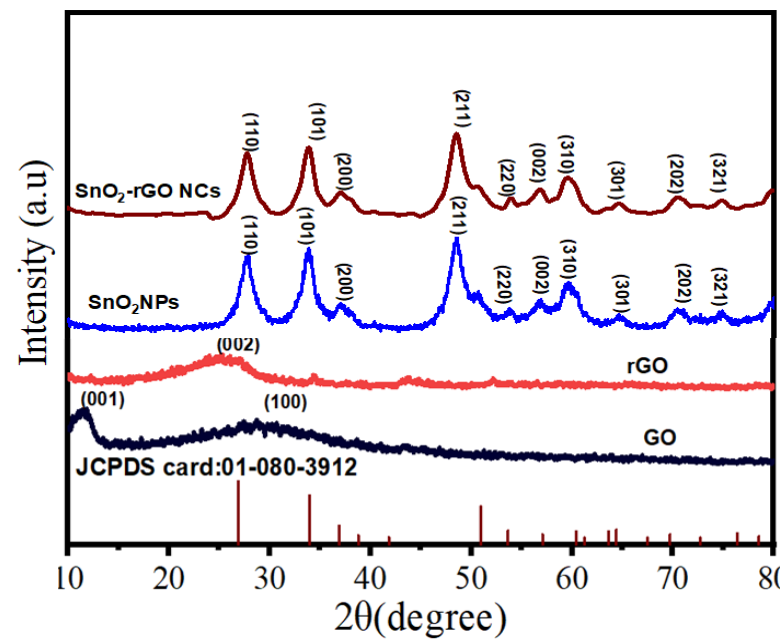
Figure 1. XRD spectra of GO, rGO, SnO 2 NPs, and SnO 2 -rGO NCs.